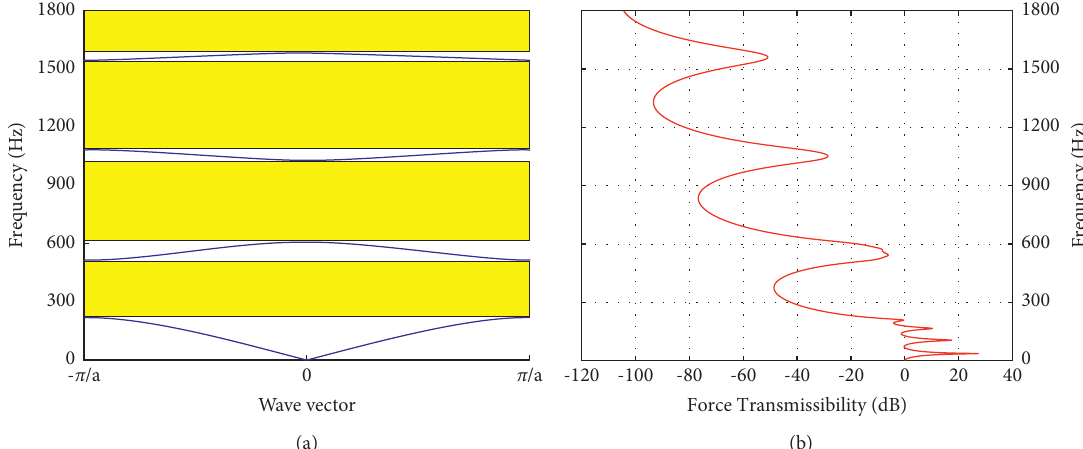
Figure 10: Band structure and force transmissibility in the passive mode. (a) Band structure. (b) Force transmissibility in the passive